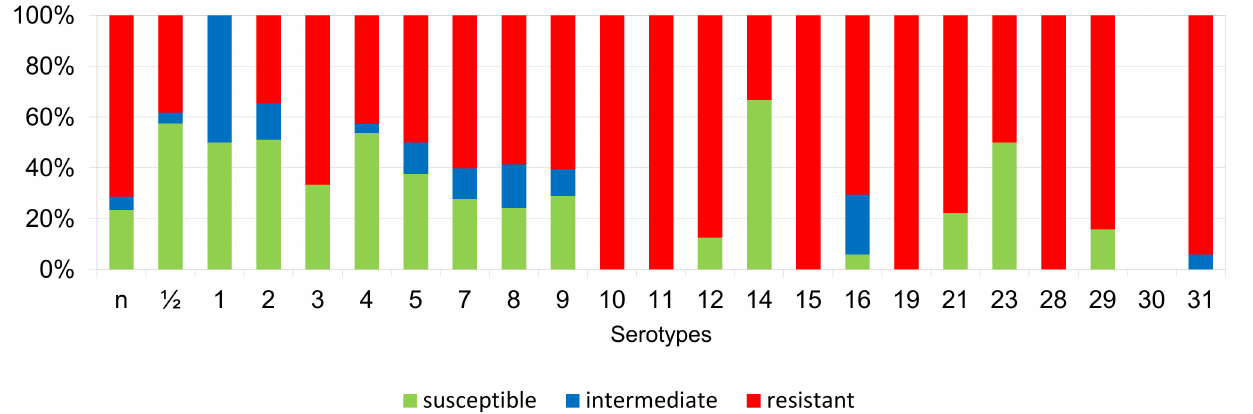
Figure 12. Percentage representation of isolates resistant, intermediately resistant, and susceptible to tulathromycin belonging to individual S. suis serotypes from the Czech Republic during 2018–2022 ( n = 506). n = non-typeable isolates.